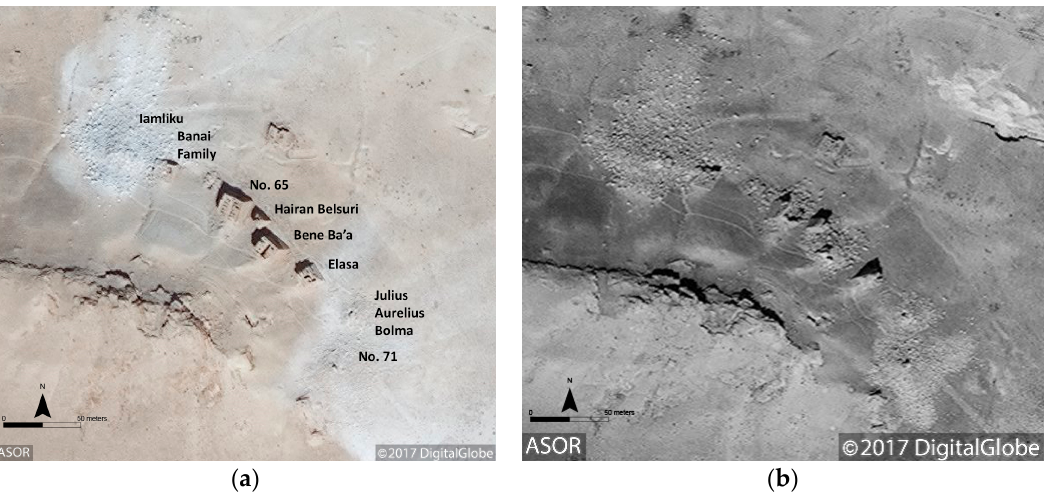
Figure 8. DigitalGlobe satellite imagery of the second and third phases of destruction in the Valley of the Tombs: ( a ) with visible damage to Tomb of Julius Aurelius Bolma and Tomb No. 71 (DigitalGlobe NextView License; 2 September 2015); ( b ) with new damage to the Tombs of Bene Ba’a, Hairan Belsuri, and No. 65 although some of the structures are still intact (DigitalGlobe NextView License; 30 March 2016).